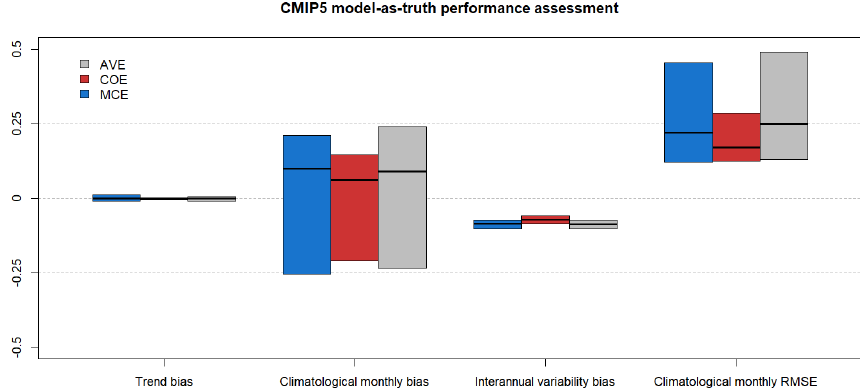
Figure 4. CMIP5 model-as-truth performance assessment results. Median, 25% and 75% percentiles of N = 39 models.